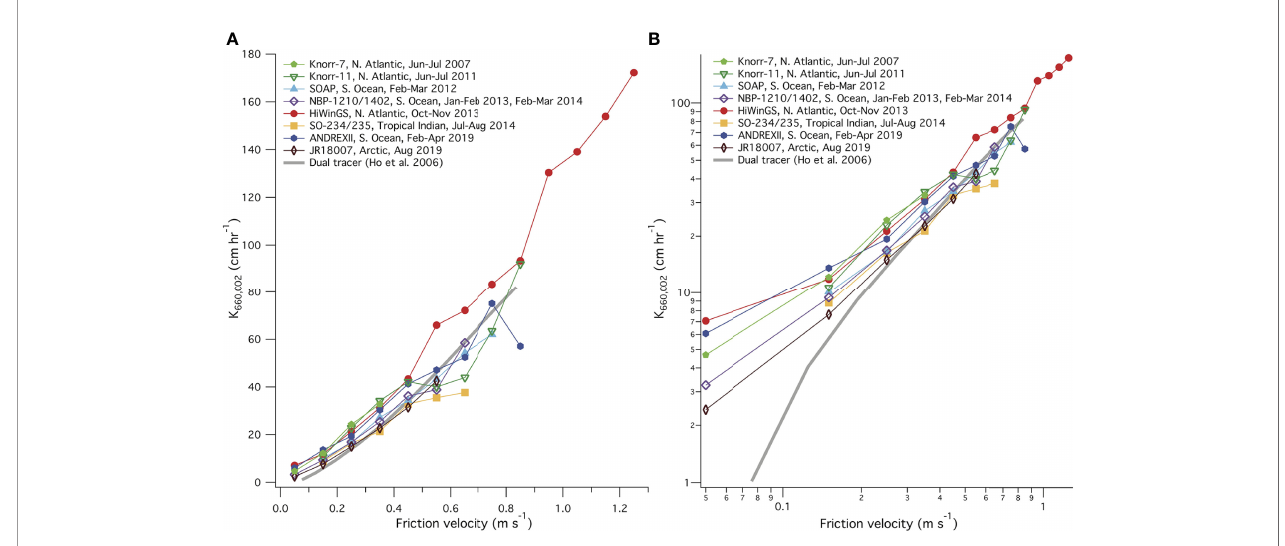
FIGURE 2 | (A) K 660 averaged to friction velocity ( u * ) bins in linear scale; (B) the same but in log-log scale. Also shown is the dual tracer relationship from Ho et al.,